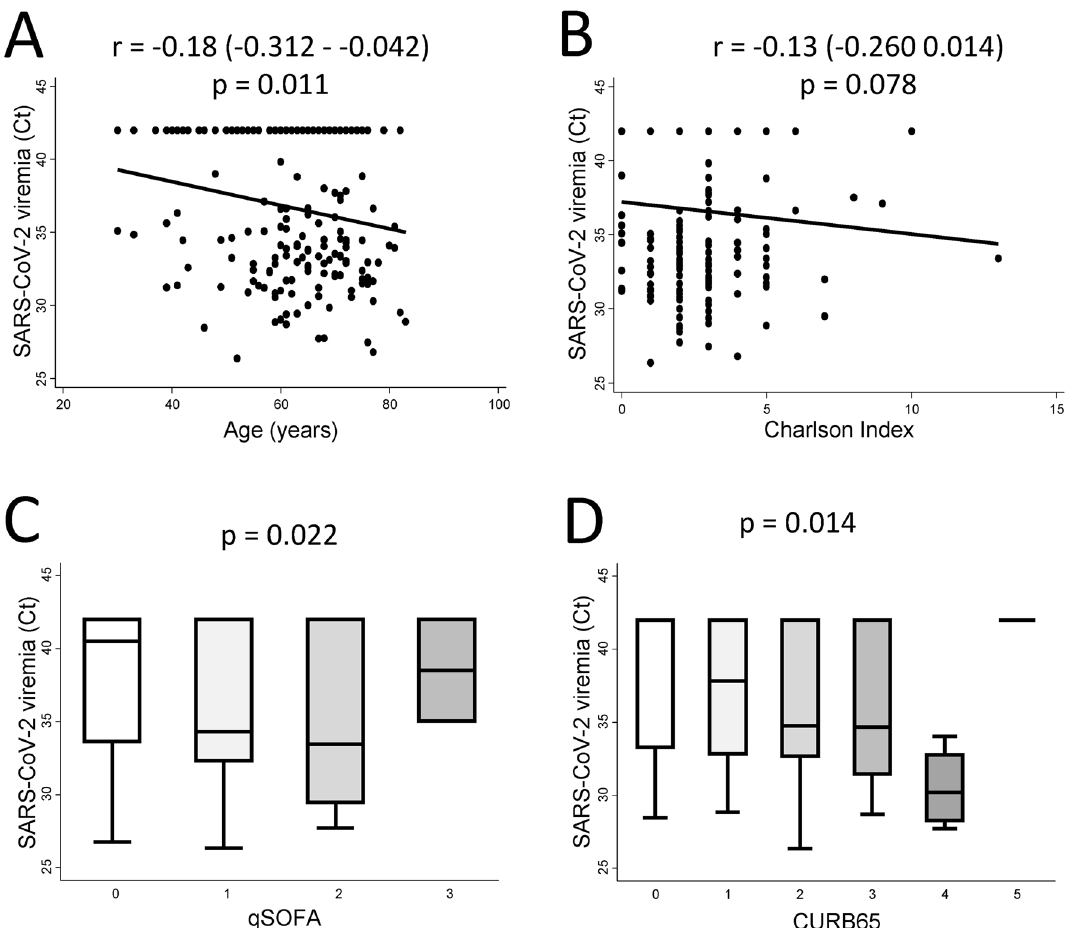
Figure 3. Association between viremia and main sociodemographic and clinical characteristics of patients hospitalized with severe COVID-19. Correlation between viremia levels (Ct value) and ( A ) age (years) and ( B ) Charlson comorbidity index (score). Distribution of viremia levels according to qSOFA index ( C ), and CURB65 scale ( D ) scores. All Ct data shown here were obtained by rRT-PCR in serum with Thermo Fisher Scientific (TFS) technique. In ( A ) and ( B ) data are shown as dot plots of the corresponding values and the fitted linear prediction (black line) obtained with the option lfit of the command twoway of Stata. Correlation